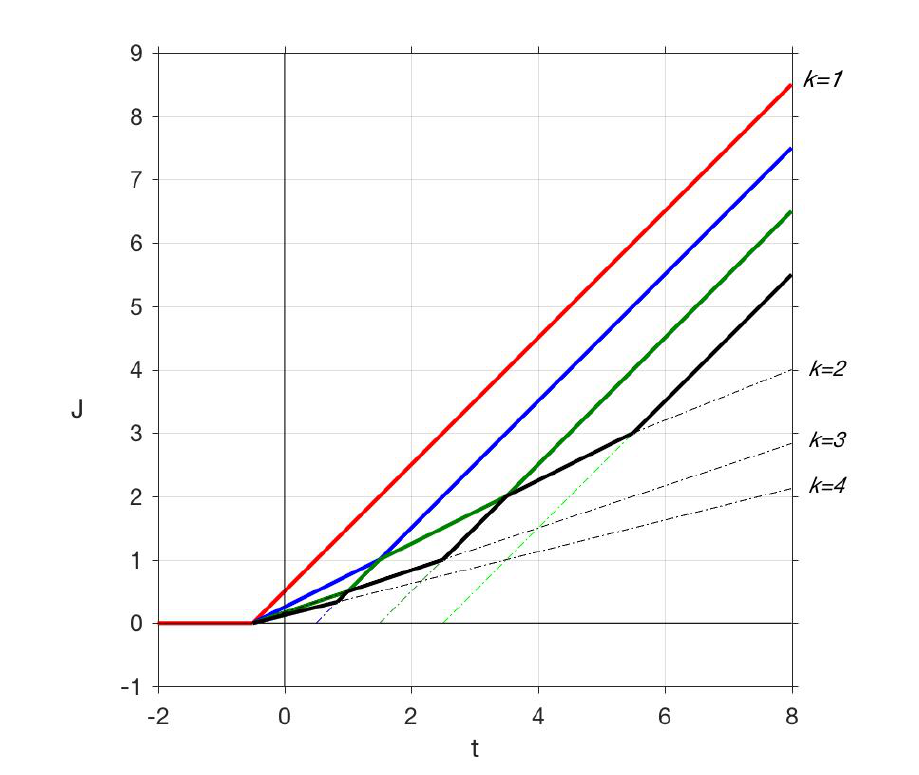
Figure 1 . Leading (in red) and next three subleading (in blue, green, black) Regge trajectories of our model for (cid:11) 0 = 1 . The sum of Regge poles turns into a branch point at J = 0 below t = (cid:0) 1 2